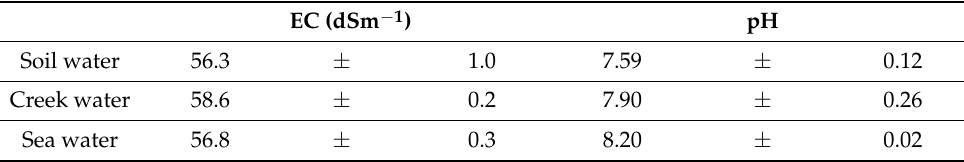
Table 2. The mean ± standard deviation value of EC and pH in soil water, creek water and seawater on Moucha Island,